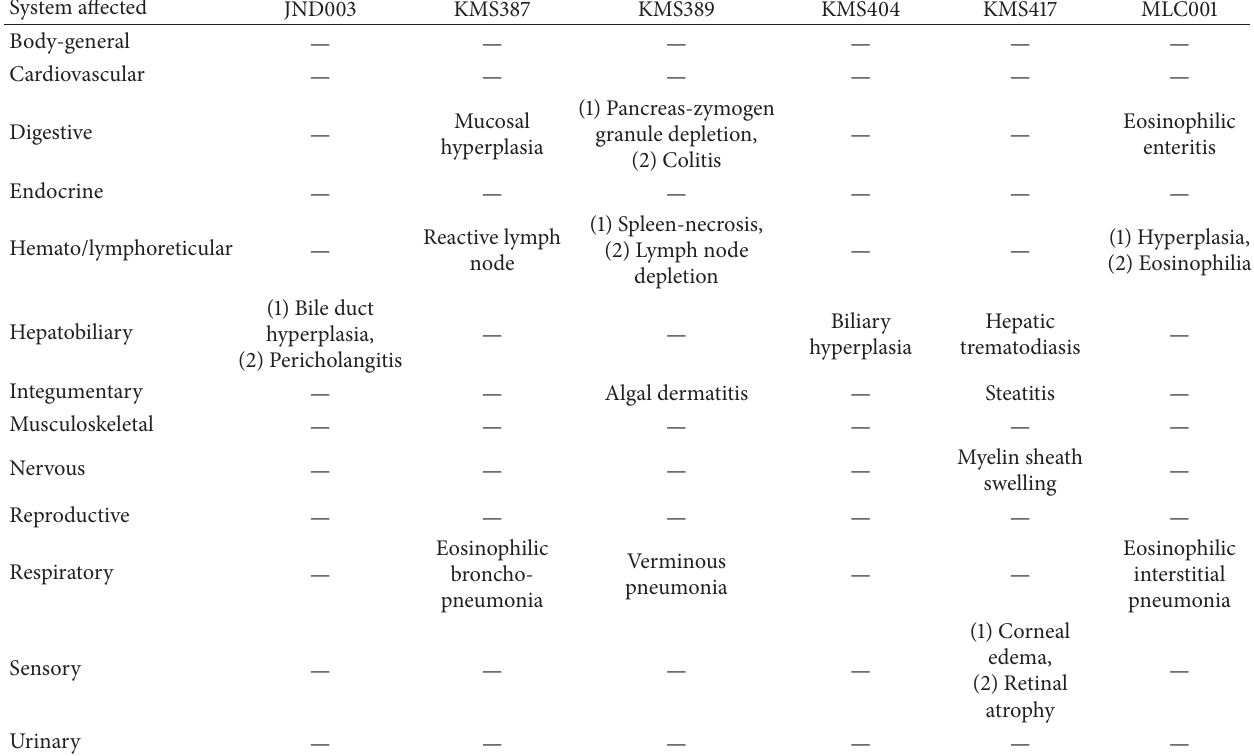
Table 3: Specific histologic findings by system for the six harbor porpoises for which tissues were submitted for histopathologic evaluation. Each porpoise is listed by its field identification